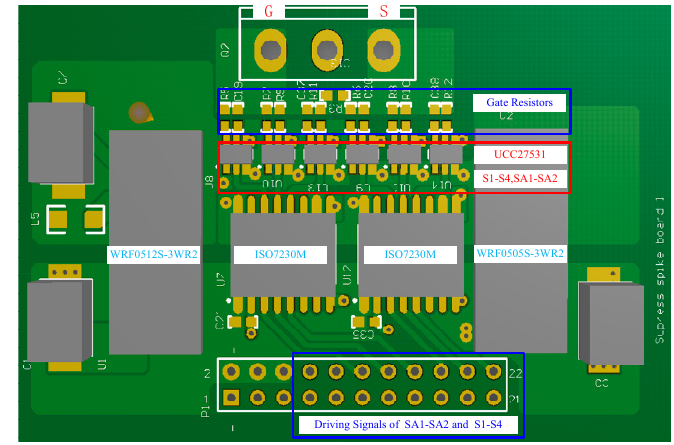
Figure 9. Printed circuit board (PCB) of the proposed gate driver.